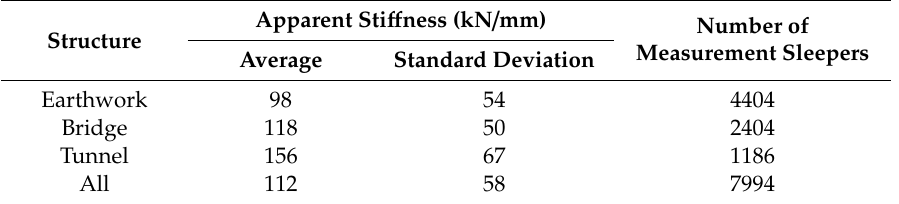
Figure 4. Relative frequency of apparent sti ff ness: ( a ) All; ( b ) Earthwork; ( c ) Bridge; ( d ) Tunnel. Table 2. Apparent sti ff ness average and standard deviation for